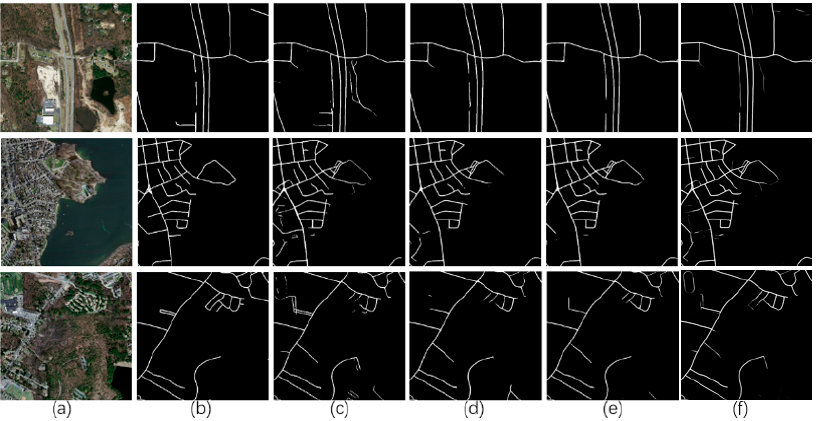
Figure 14. Road extraction results in general scene images; ( a ) input image; ( b ) label image; ( c ) D-LinkNet; ( d ) S-DenseNet; ( e ) SD-DenseNet; ( f ) SDG-DenseNet.